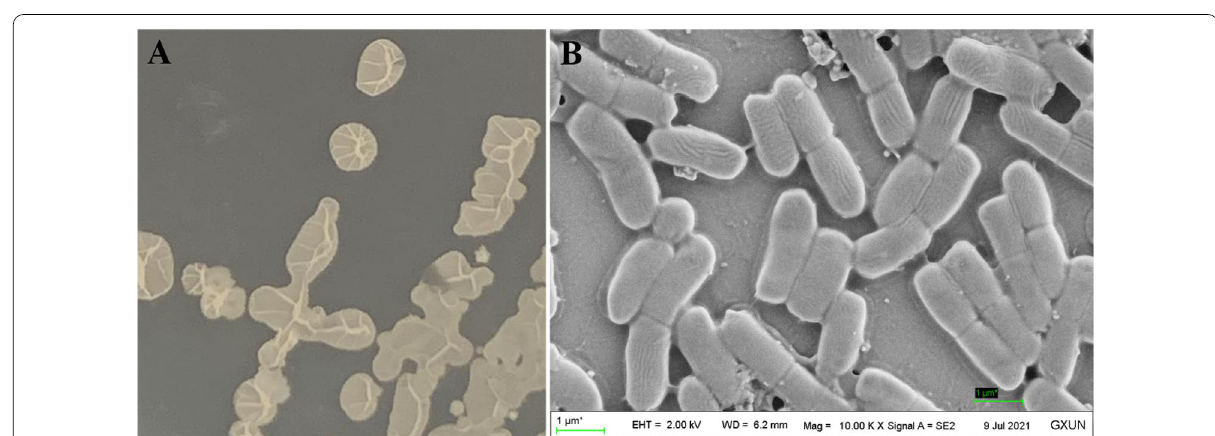
Fig. 5 Morphology of Gxun-6 strain. A Colony morphology of Gxun-6 on LB plate; B Scanning electron microscopy of Bacillus siamensis Gxun-6